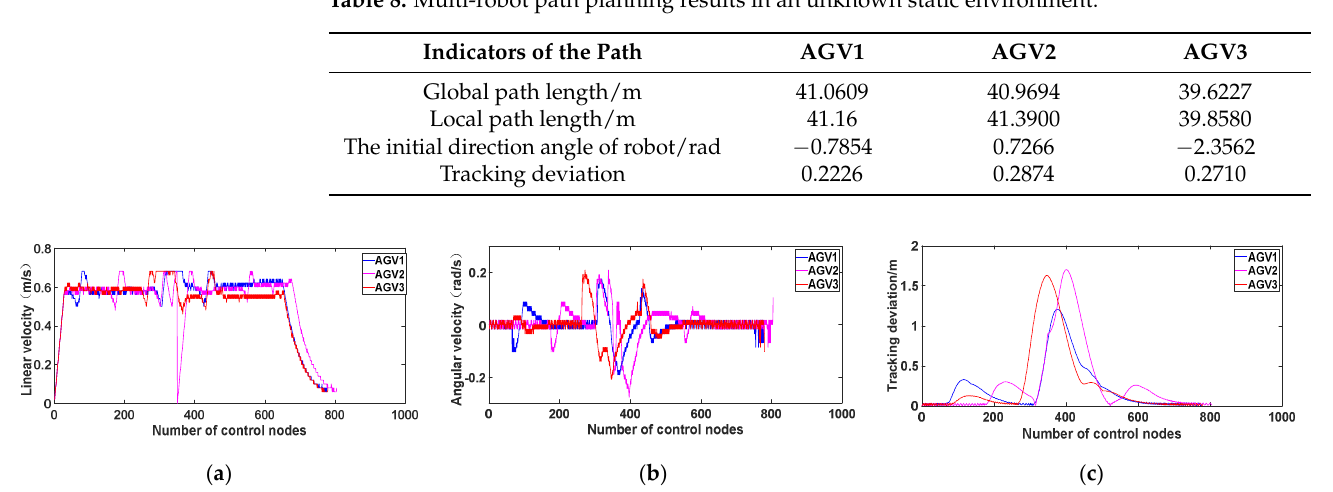
Figure 24. Multi−robot parameter comparison. ( a ) Comparison of linear velocity. ( b ) Comparison of angular velocity. ( c ) Comparison of tracking deviation.